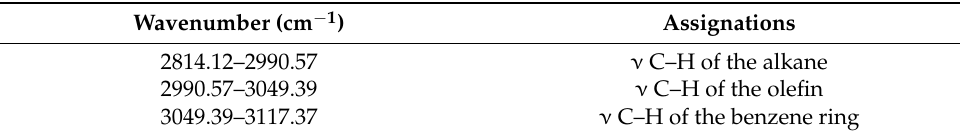
Figure 7. FTIR of SBS, asphalt, and SBS–asphalt. Table 6. Assignations of the bands of the SBS